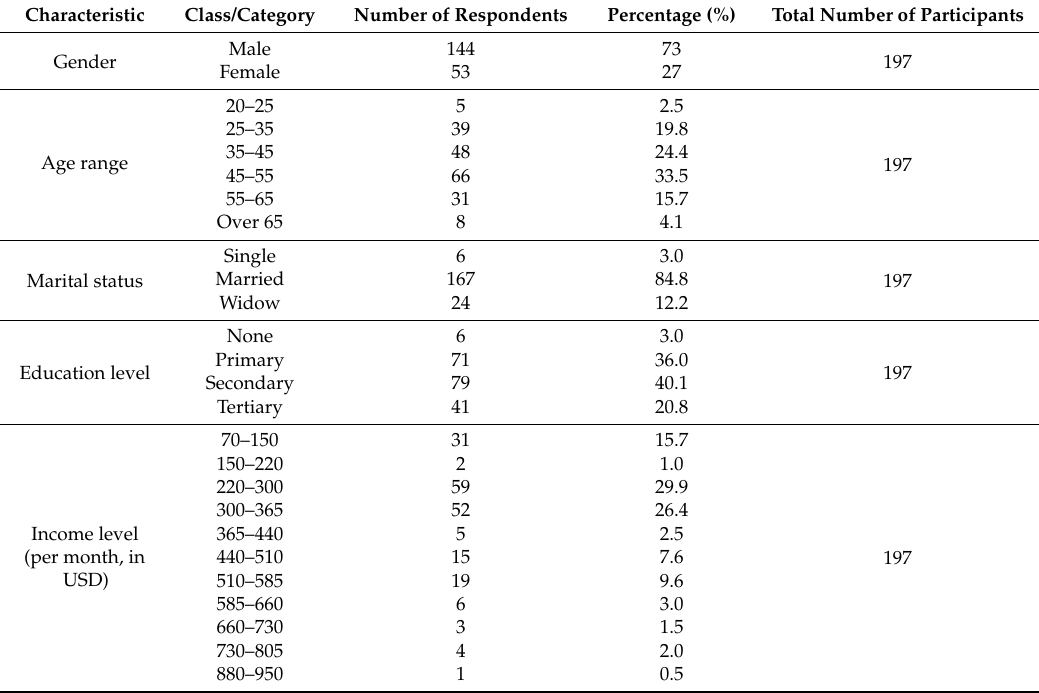
Table A3. Main characteristics of participants to household survey.